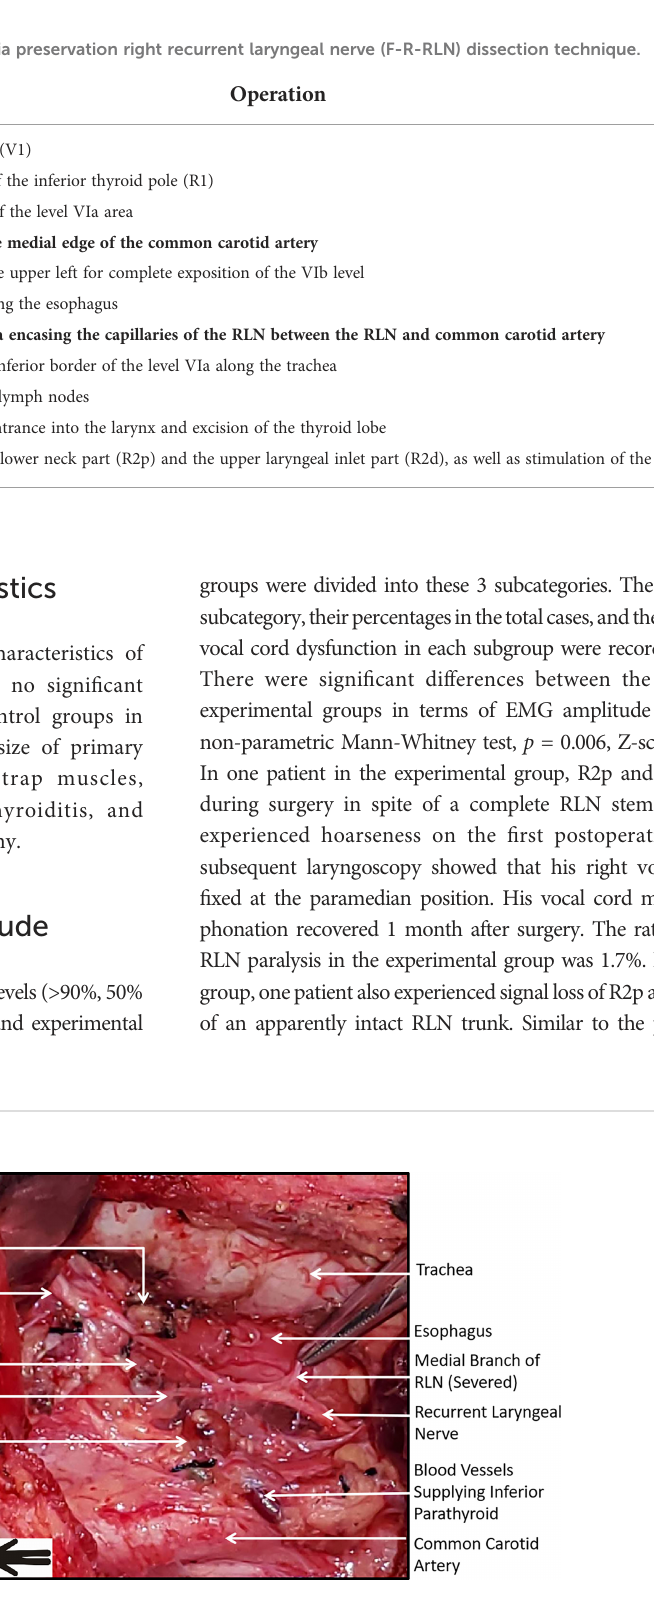
FIGURE 3 Operative fi eld after Fang ’ s capillary fascia preservation right recurrent laryngeal nerve (F-R-RLN) dissection technique: the capillary network encased by fascia between the RLN and the common carotid artery and the branches of RLN running laterally are preserved.